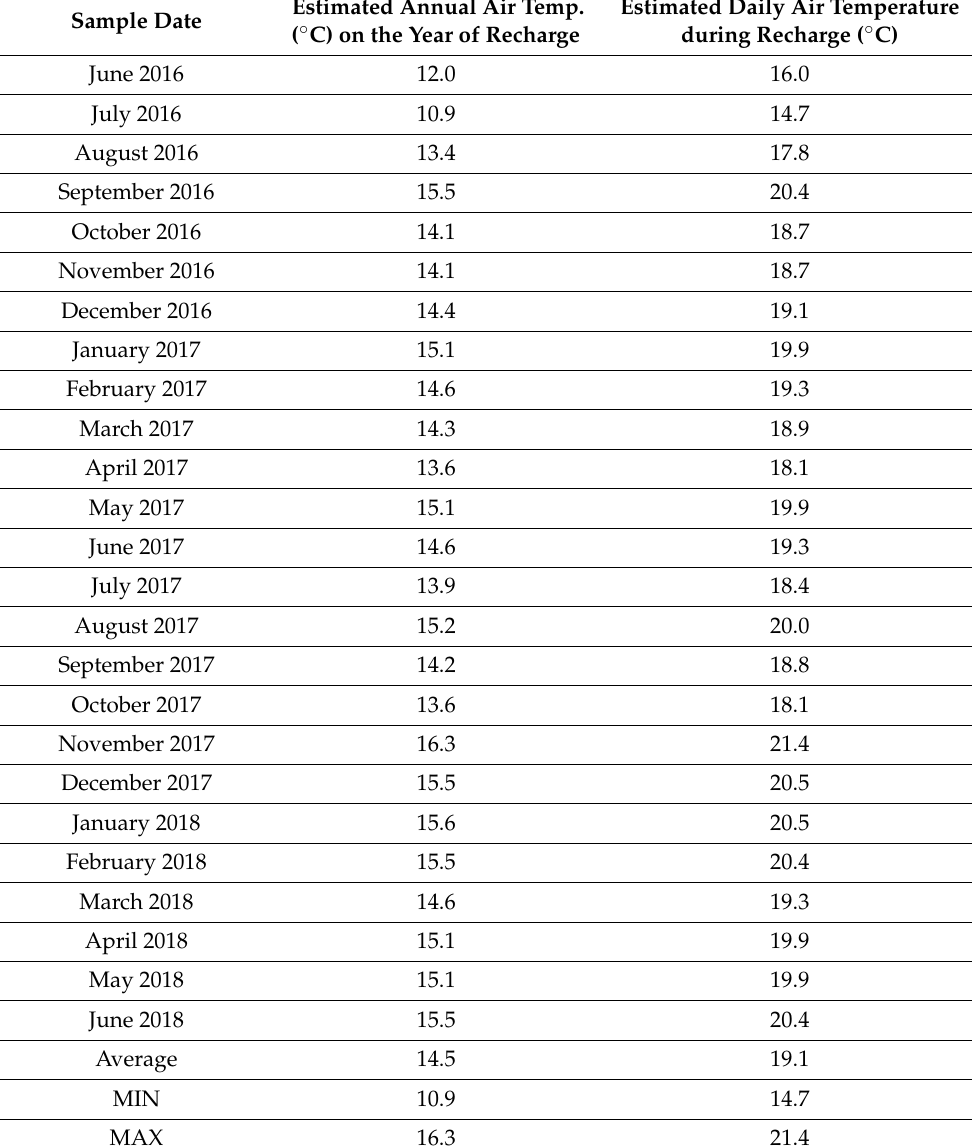
Table 3. The estimated mean annual and daily air temperatures at the time of recharge for the Albert Farm spring samples over the 25